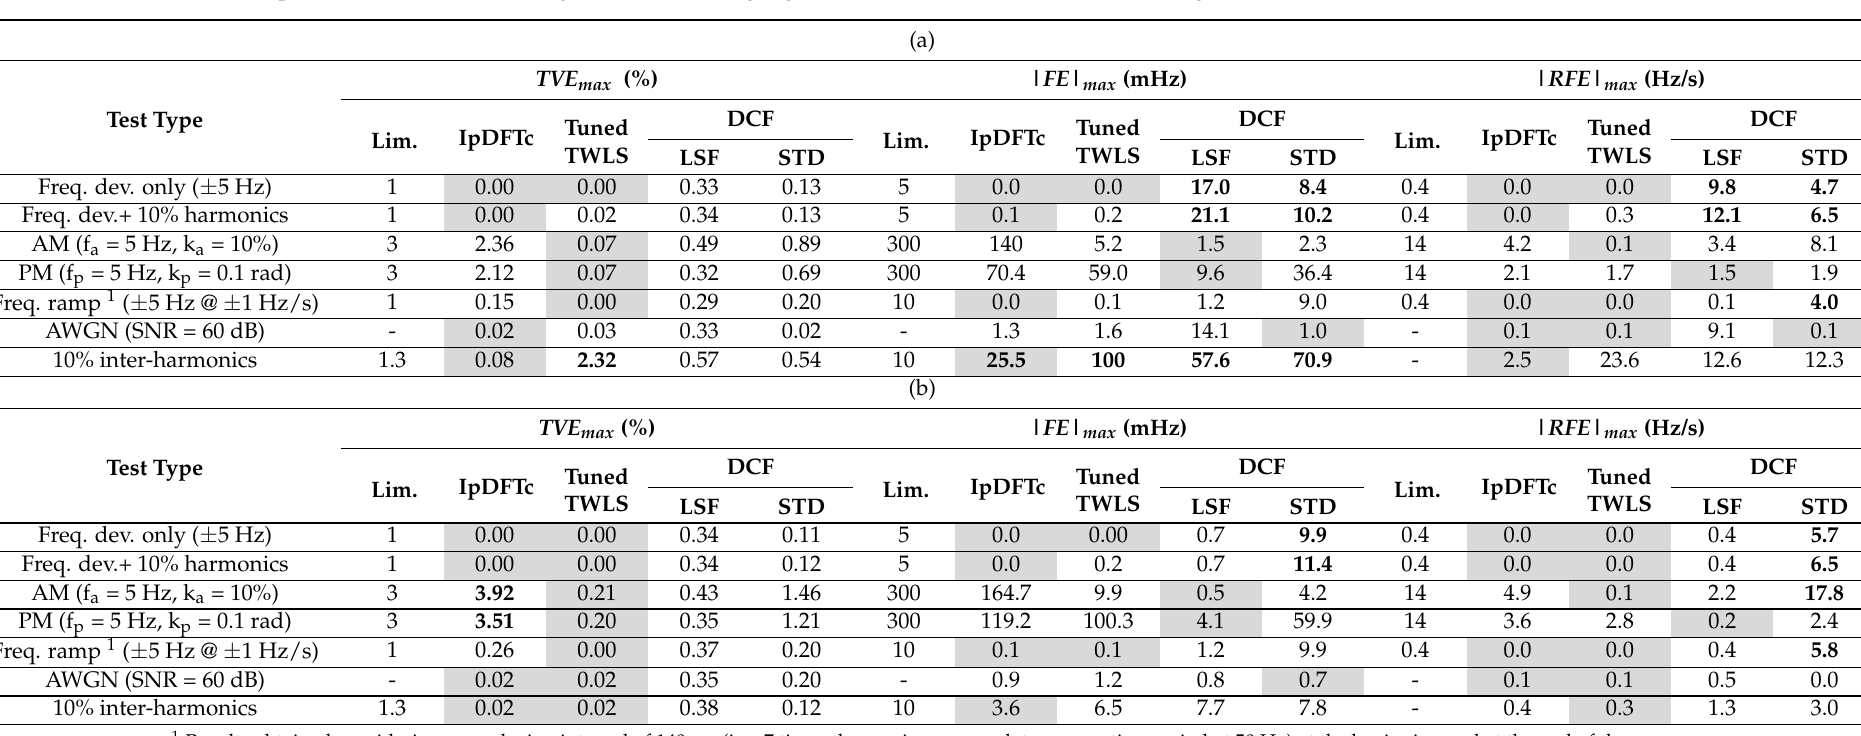
Table 5. Maximum TVE, |FE| and |RFE| values obtained with the estimation algorithms for PMUs described in Section 2 over 6-cycle (a) and 8-cycle (b) observation intervals. All the testing conditions, except the one with the additive wideband noise, are specified in the IEEE/IEC Standard 60255-118-1:2018 for M Class PMUs [10]. The limits mentioned in the Standard (when defined) are also reported. The values exceeding such limits are highlighted in bold, whereas the cells containing the best results obtained in each test are